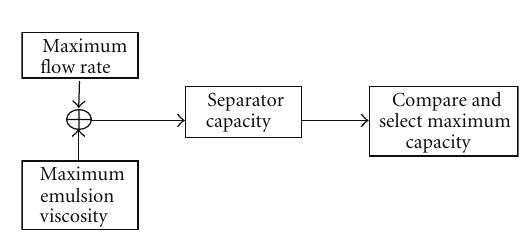
Figure 2: Simulated production forecast.